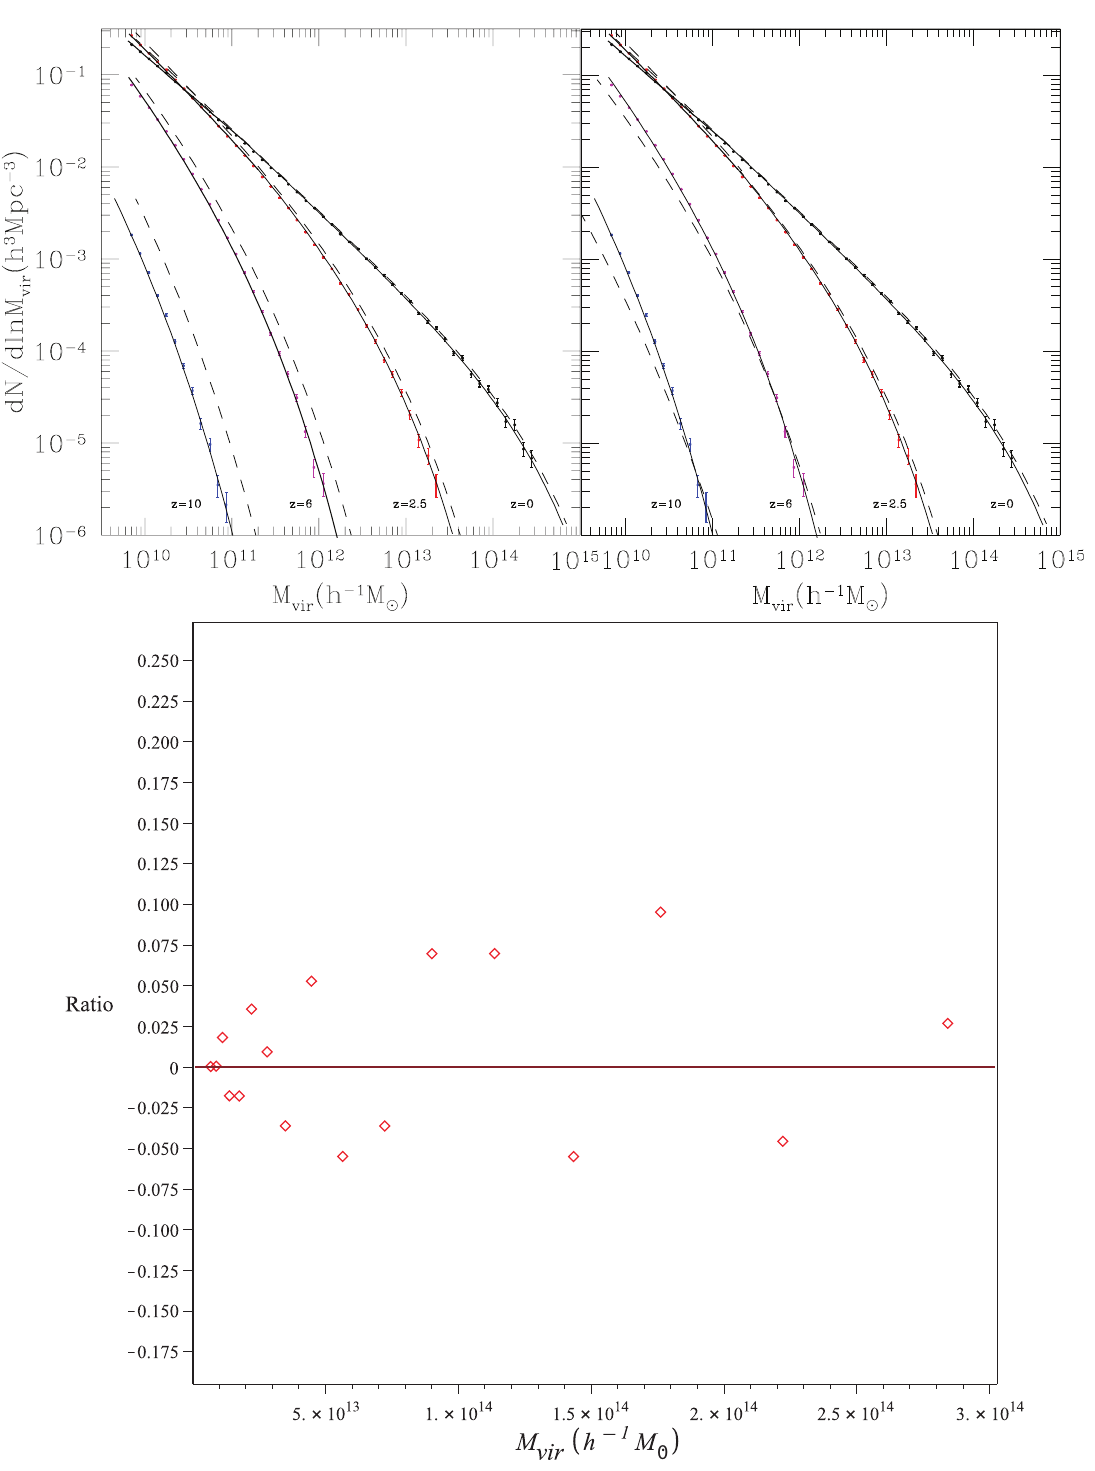
Figure 2. Comparison of the mass functions of ST1 and this work with the Bolshoi MF. Left panel: the dashed line represents the ST1 MF, while the solid line ours. Diamonds represent the Bolshoi MF. From left to right z receives the values 10, 6, 2.5, 0. Right panel: Curves and symbols are as in the left panel, except that now the dashed line represents the correction by Klypin to the ST MF. Bottom panel: the ratio between the Klypin’s data and our mass